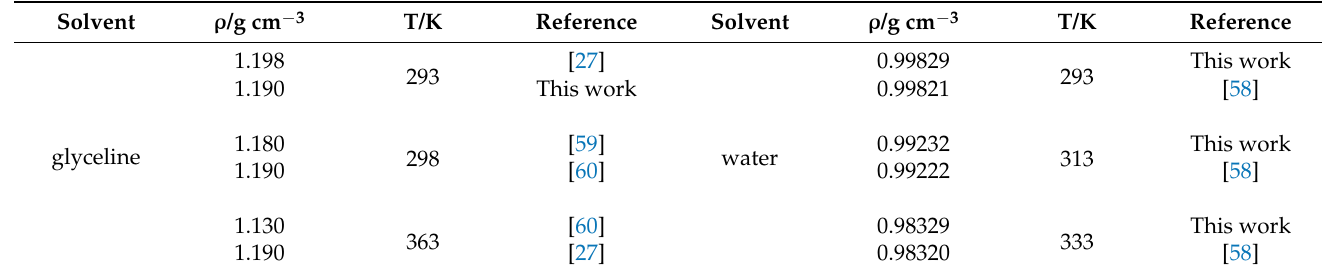
Figure 3. Densities of MWCNTs mixtures (0.2–1.0 mg cm − 3 ) in glyceline ( a ), water ( b ) as a function of temperature, and density ratio of AgMWCNTs (0.4 mg cm − 3 ) Samples B, D and E ( c ), A and C ( d ) as a function of temperature, in glyceline and water. Table 2. Density values for glyceline and water at different temperatures (published and obtained